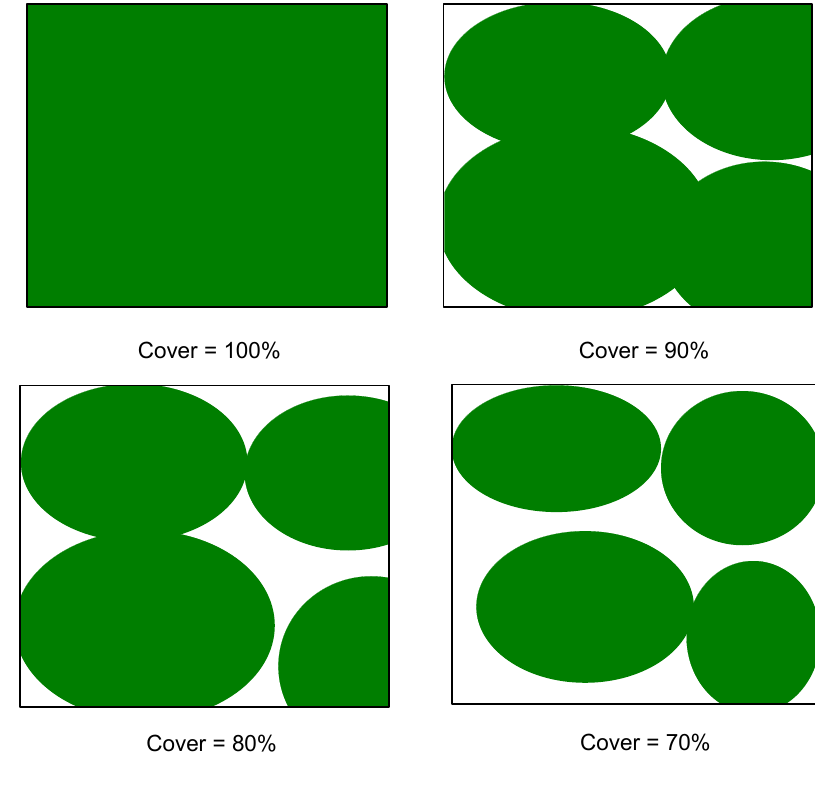
Figure 2. Tree scenes with variable tree ground covers from 100% down to 70%. Discrete Anisotropy Radiative Transfer (DART) works with an infinite scene comprised of a repetitive pattern of these tree